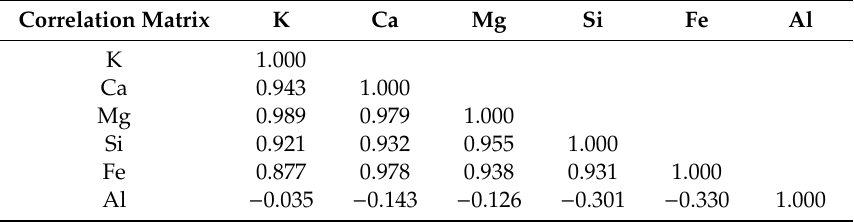
Table 4. Correlation coefficient matrix of the outlet solution ions.